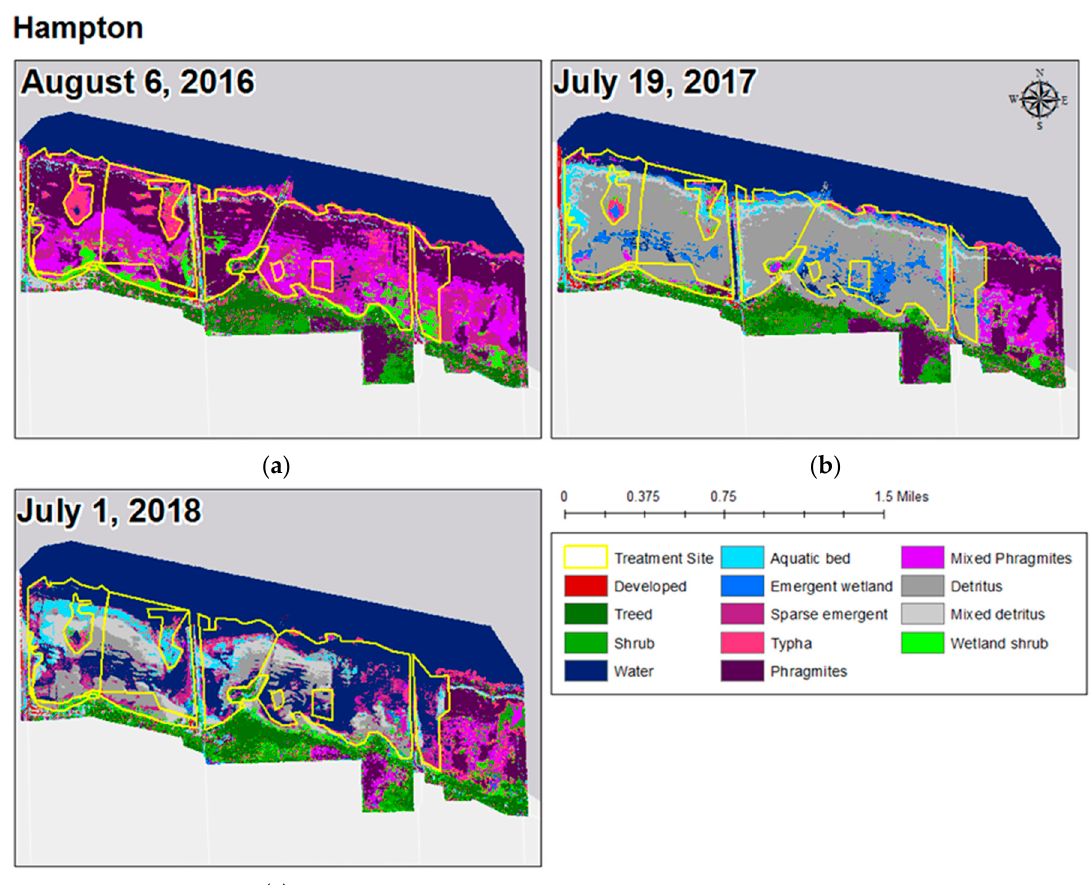
Figure 6. Maps of the Hampton site for ( a ) 2016, ( b ) 2017, and ( c ) 2018 based on Worldview-2 imagery. Table 4. Summary of pre- and post- treatment Phragmites extent as measured using high-resolution classification ap- proach of Worldview-2.